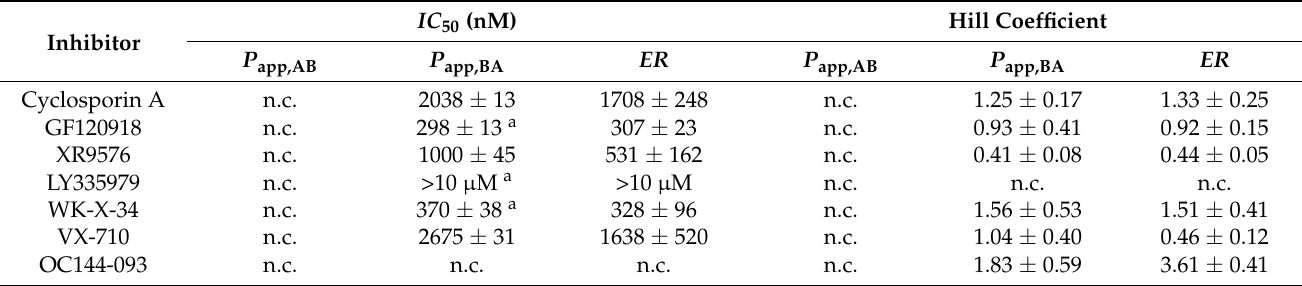
Table 2. IC 50 values and Hill coefficient of selected inhibitors on apparent AP-to-BL and BL-to-AP permeability, and ER of mitoxantrone in Caco-2 cell